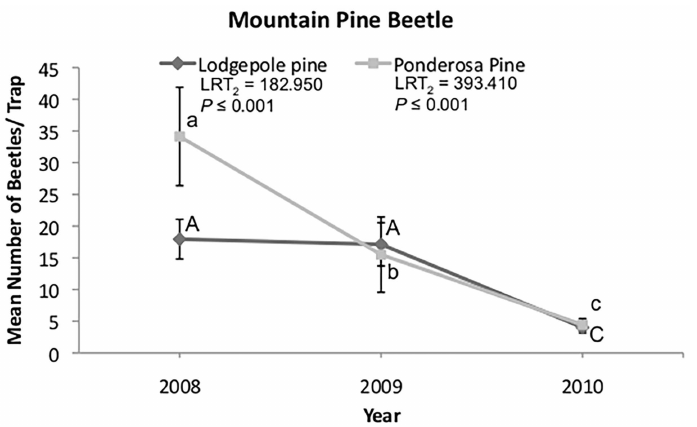
Fig 4. Mean ± SE numbers of mountain pine beetles caught in unbaited flight intercept traps. Data reflect 3 years post-fire in lodgepoleand ponderosa pine sites. Different letters denote significant differences ( α (cid:20) 0.05) between years within a species from generalizedlinear mixed models with Tukey HSD pairwise comparisons. doi:10.1371/journal.pone.0164738.g004 mass or strip attacks had experiencedover twice the degree of TCD, CVS, and BCI, 9.2 times the degree of BSP, and 14.3 times the degree of CVC as lodgepole pines that underwent mass or strip attacks. Significant relationships between degree of fire injury and incidence of mountain pine beetle attack were observedfor both continuous and burn categorical metrics (S4 and S5 Tables). The incidence of attack showed a curvilinearrelationship with TCD, BSP, and BCR, and an initially increasing but subsequently leveling relationship with CKR (Fig 6). Similar to lodgepolepine, ponderosa pines that underwent mass attacks had greater fire-injury than those with strip or failed attacks for most measures (Table 4). For example, ponderosa pines Table 3. Number of lodgepole and ponderosa pines attacked by mountain pine beetle (Top) and Ips spp., other Scolytinae and woodborers (Bot- tom) each year and all years pooled. Year All